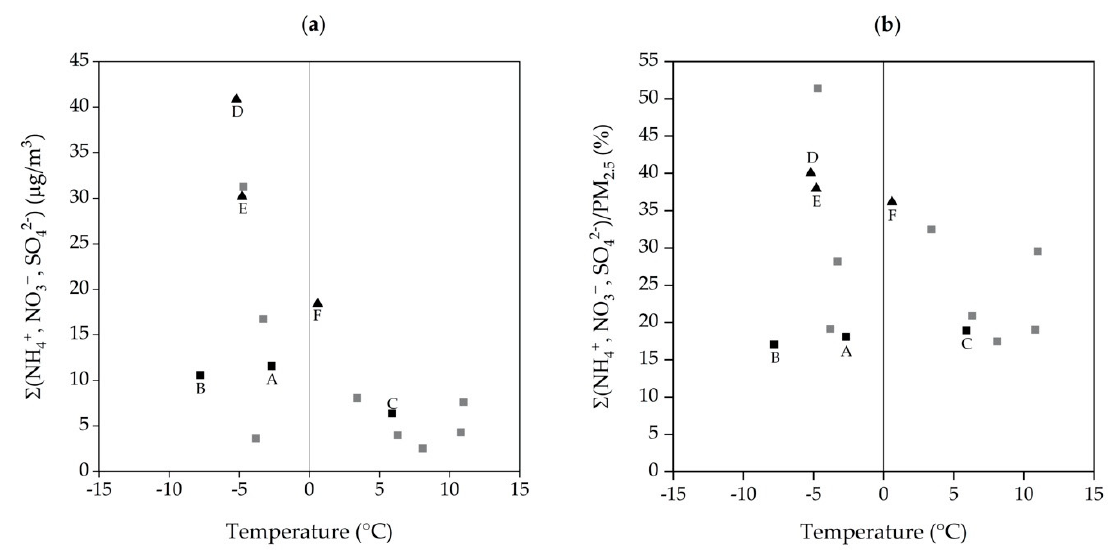
Figure 4. ( a ) Temperature dependence of mass concentrations and ( b ) relative contributions of major ions (nitrate, ammonium, sulfate) to PM 2.5 samples at the urban sampling site in Graz DB, 2 January–31 March 2017. Black highlighted squares mark time periods with DB / BB PM 10 ratios > 2 (A: 2 January–3 January 2017; B: 11 January–12 January 2017; C: 21 February–23 February 2017). Black highlighted triangles mark time periods with DB / BB PM 10 ratios ≤ 1.5 (D: 22 January–23 January 2017; E: 31 January–2 February 2017 and F: 9 February–17 February 2017). Remaining data points are shown by grey squares.